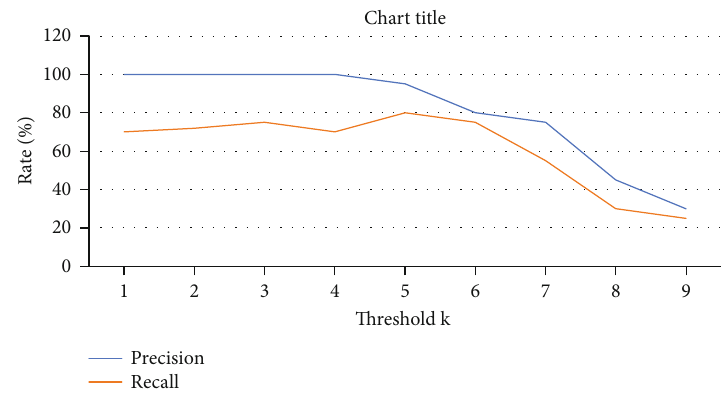
Figure 1: Variation in precision and recall under di ff erent matching thresholds are